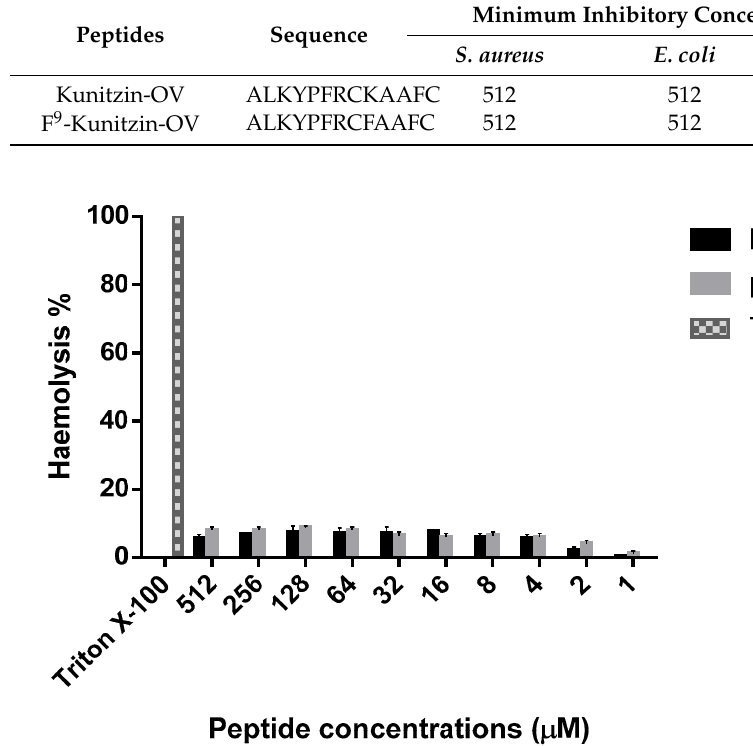
Figure 4. The haemolytic activity of Kunitzin-OV and F 9 -Kunitzin-OV against horse blood cells. Triton X-100 was severed as a positive control with 100% haemolysis.